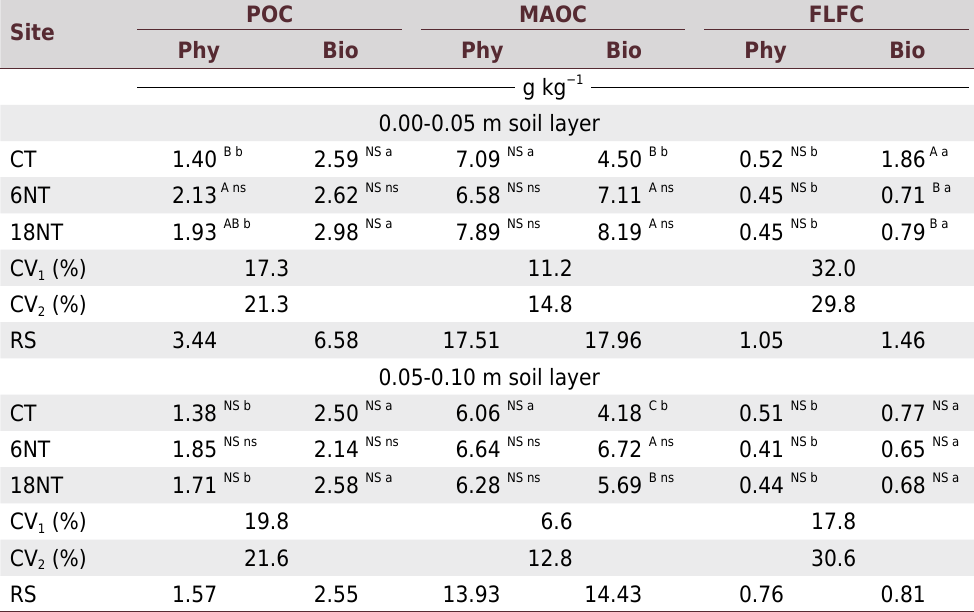
Table 2. Distribution of organic carbon in physical fractions of physicogenic (Phy) and biogenic (Bio) aggregates from 0.00-0.05 and 0.05-0.10 m soil layers under different management systems in the Cerrado region of Uberaba, Minas Gerais, Brazil POC MAOC Site